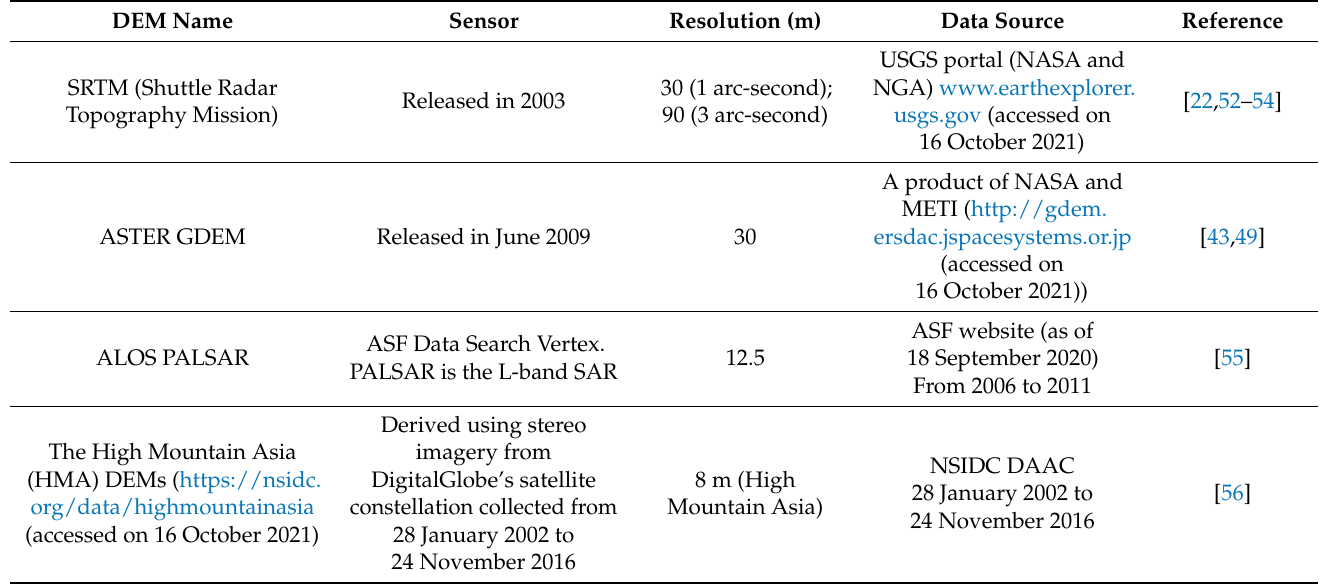
Table 3. List of open Digital Elevation Models